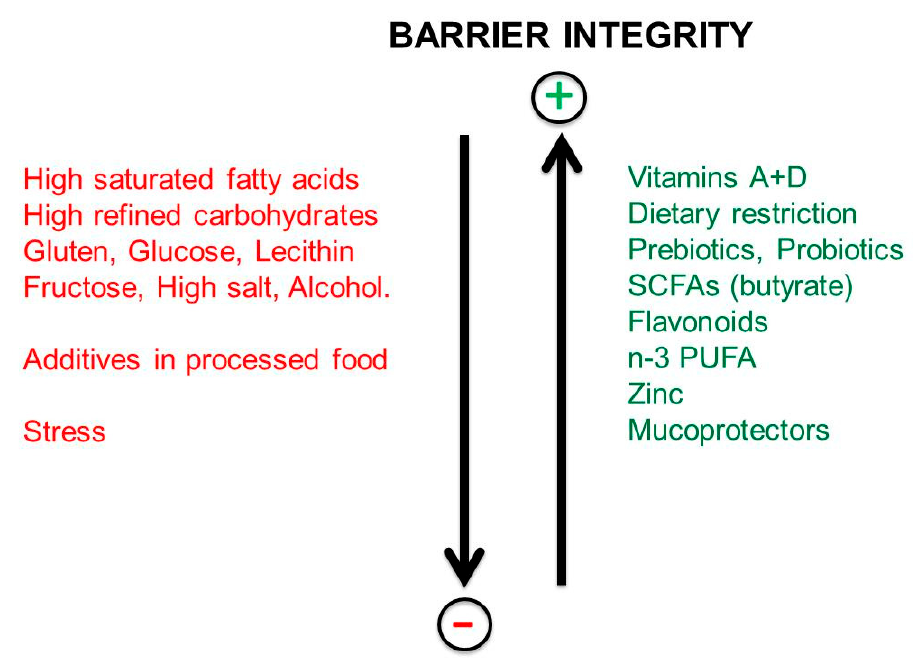
Figure 7. E ff ects of dietary factors and stressors on the integrity of the intestinal Figure 7. Effects of dietary factors and stressors on the integrity of the intestinal barrier.